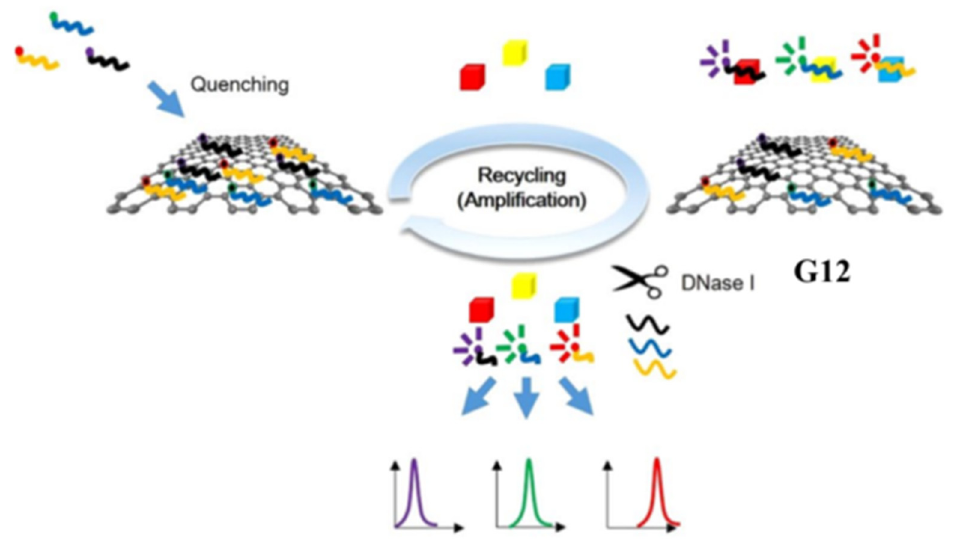
Figure 14. Schematic representation of the GO-based aptasensor ( G12 ) for antibiotics via CESA. Reprinted from [69] with permission from Nature Scientific reports.